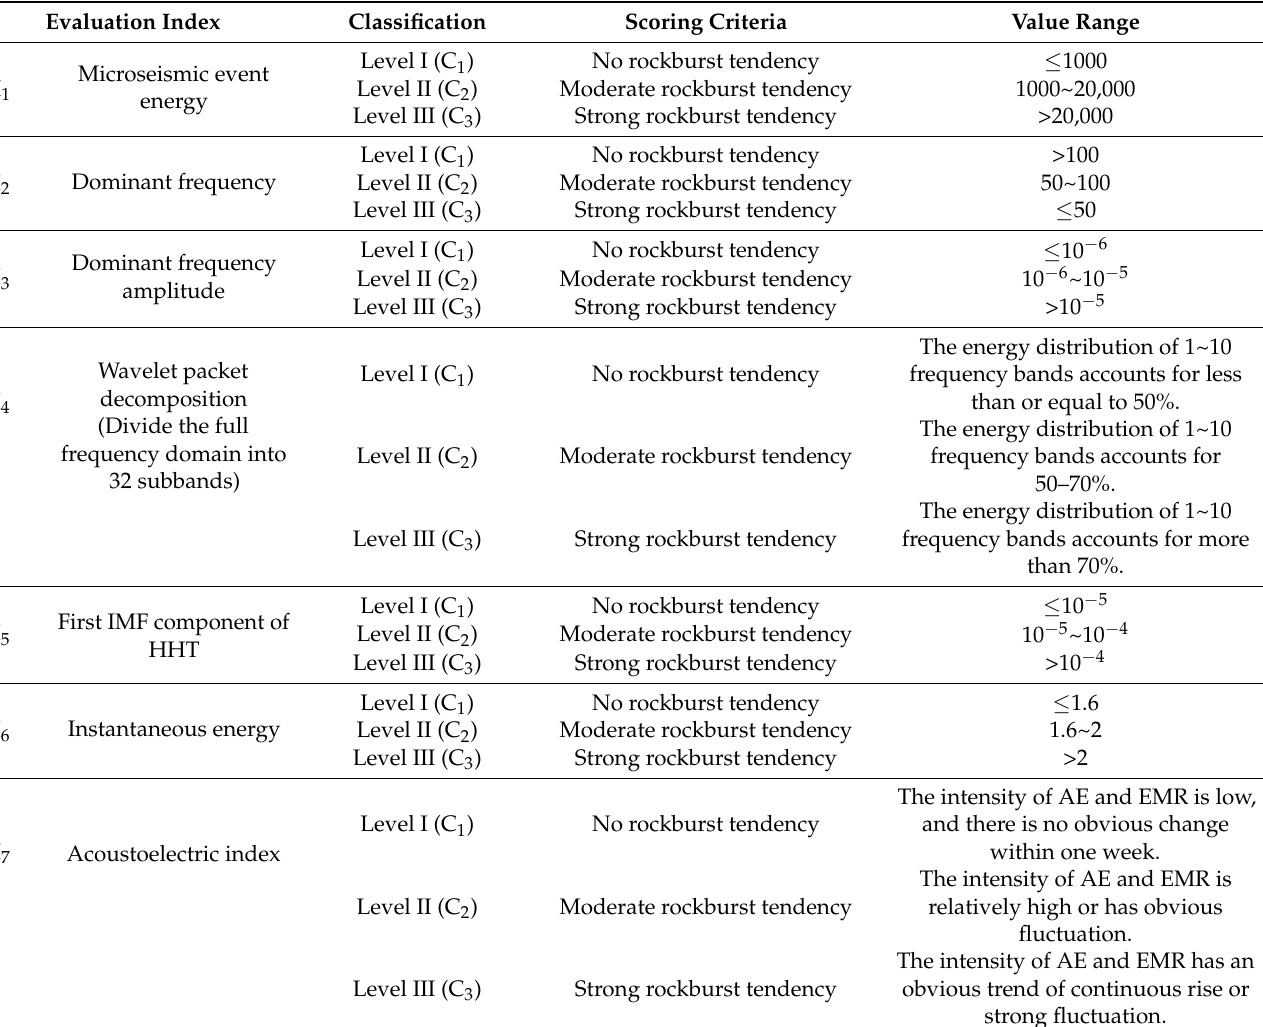
Table 2. Grading criteria for impact propensity evaluation indicators.